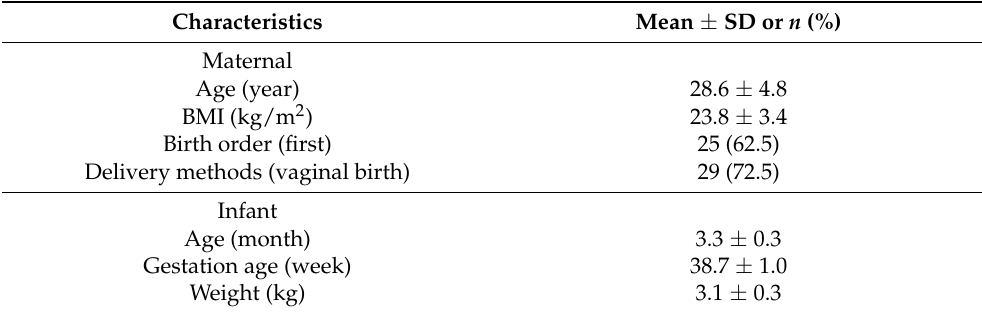
Table 2. Maternal and infant characteristics ( n = 40).